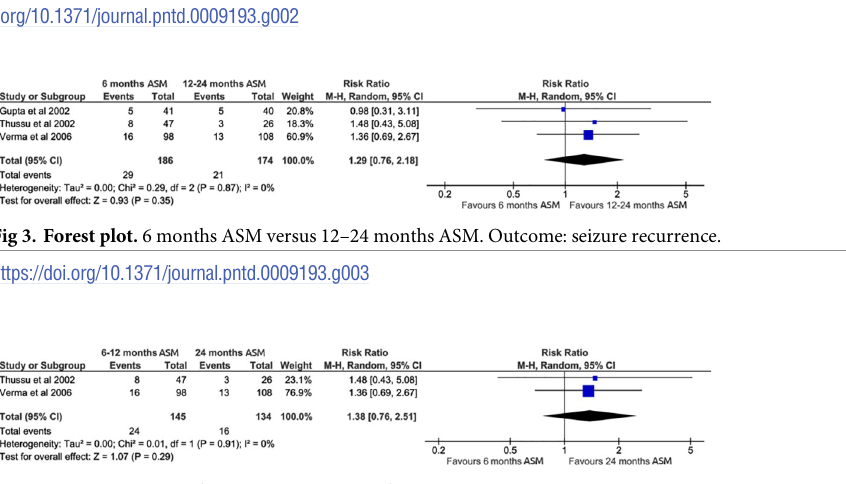
Fig 4. Forest plot. 6 months ASM versus 24 months ASM. Outcome: seizure recurrence.